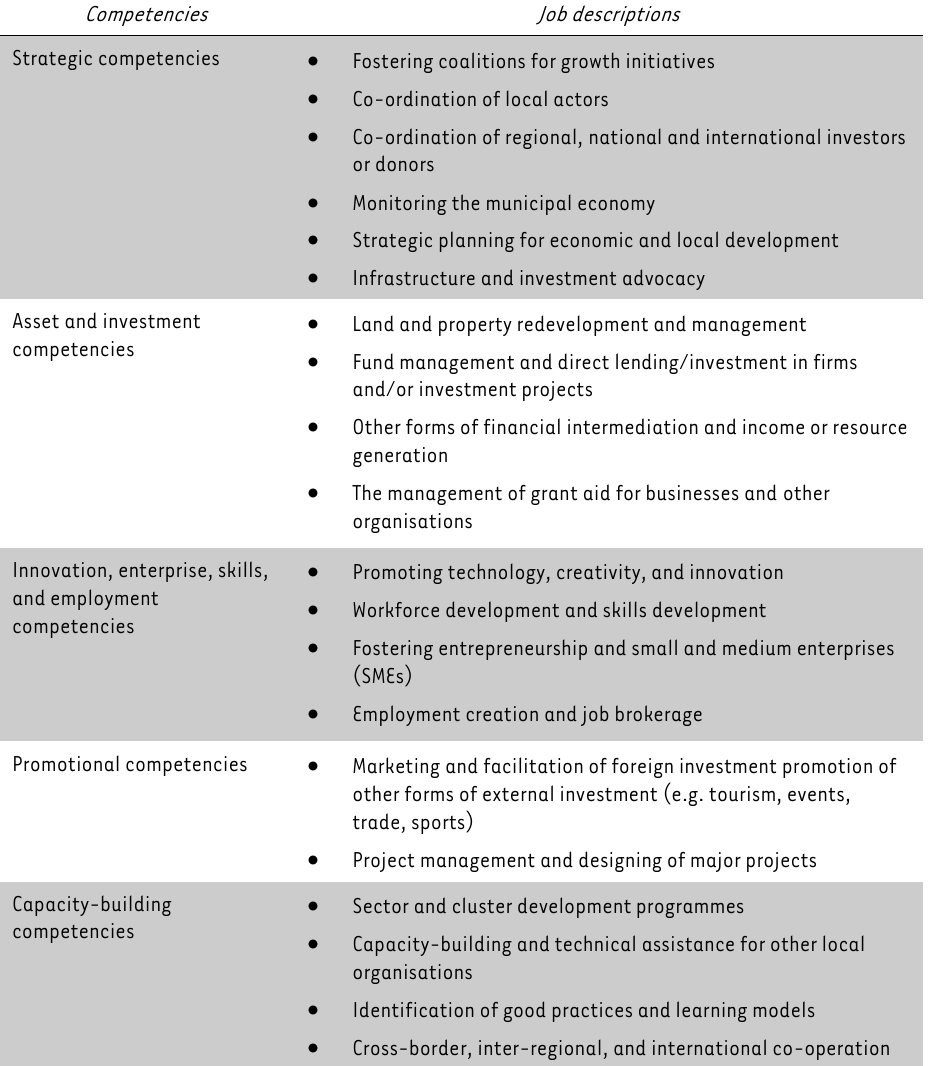
TABLE 1: OECD/OLEDA competencies and job descriptions relating to LED practitioners